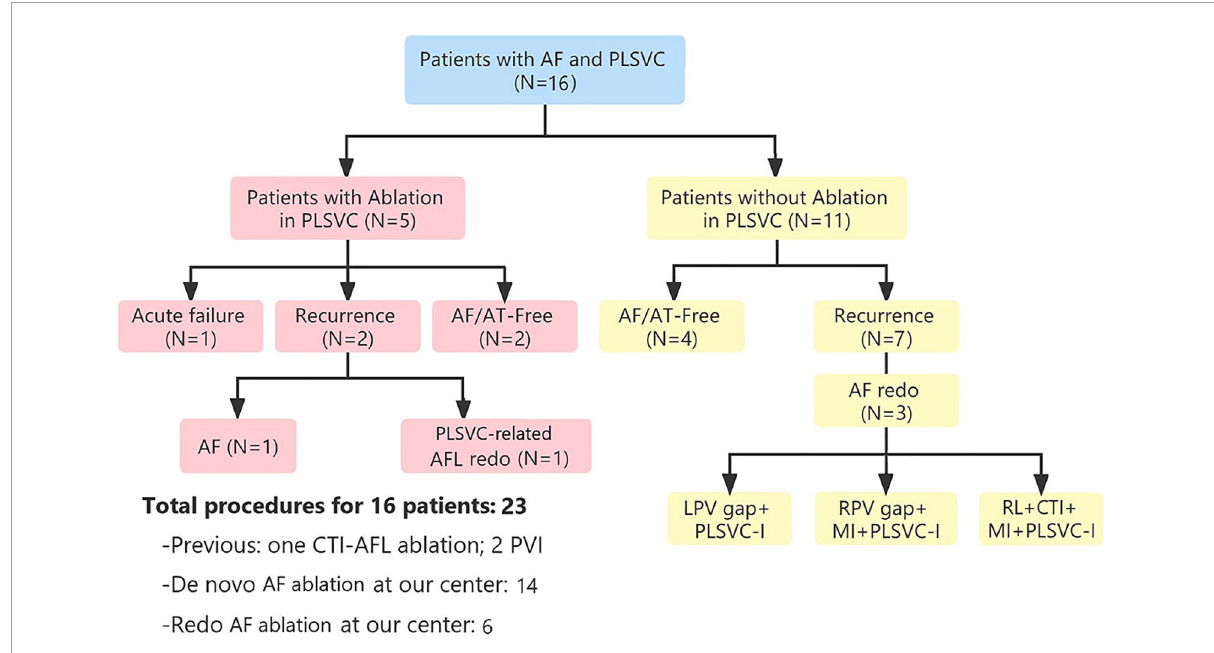
FIGURE2 Flow diagram showing procedural and follow-up outcomes. AF, atrial fibrillation; AFL, atrial flutter; AT, atrial tachycardia; CTI, cavotricuspid isthmus; LPV, left pulmonary vein; PLSVC, persistent left superior vena cava; RPV, right pulmonary vein.